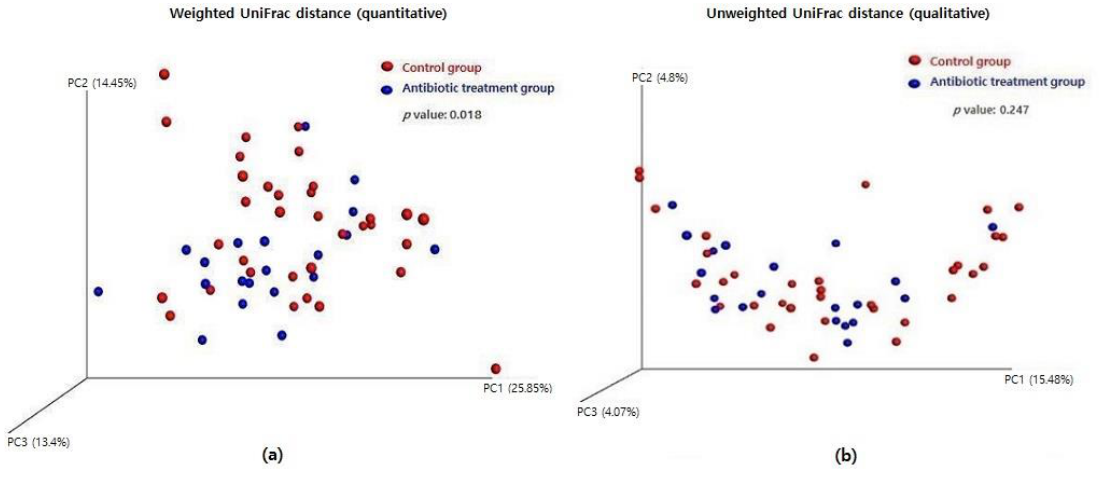
2 Figure 6. Difference of beta diversity between the control group and the antibiotic treatment group: ( a ) weighted UniFrac distance (quantitative) and ( b ) unweighted UniFrac distance (qualitative). 2.4. Difference in Metabolic Activity between Antibiotic-Treated and Control Infants The Phylogenetic Investigation of Communities by Reconstruction of Unobserved 2 States (PICRUSt) analysis performed demonstrated a significant difference in gut micro- biome metabolic activity between the two groups (Table 2). Significantly more genes were expressed in naphthalene degradation, glycolysis gluconeogenesis, and lipoic acid metabolism in the antibiotic treatment group than in those in the control group, whereas this situation was reversed with gene expression in porphyrin and chlorophyll metabolism and fatty acid